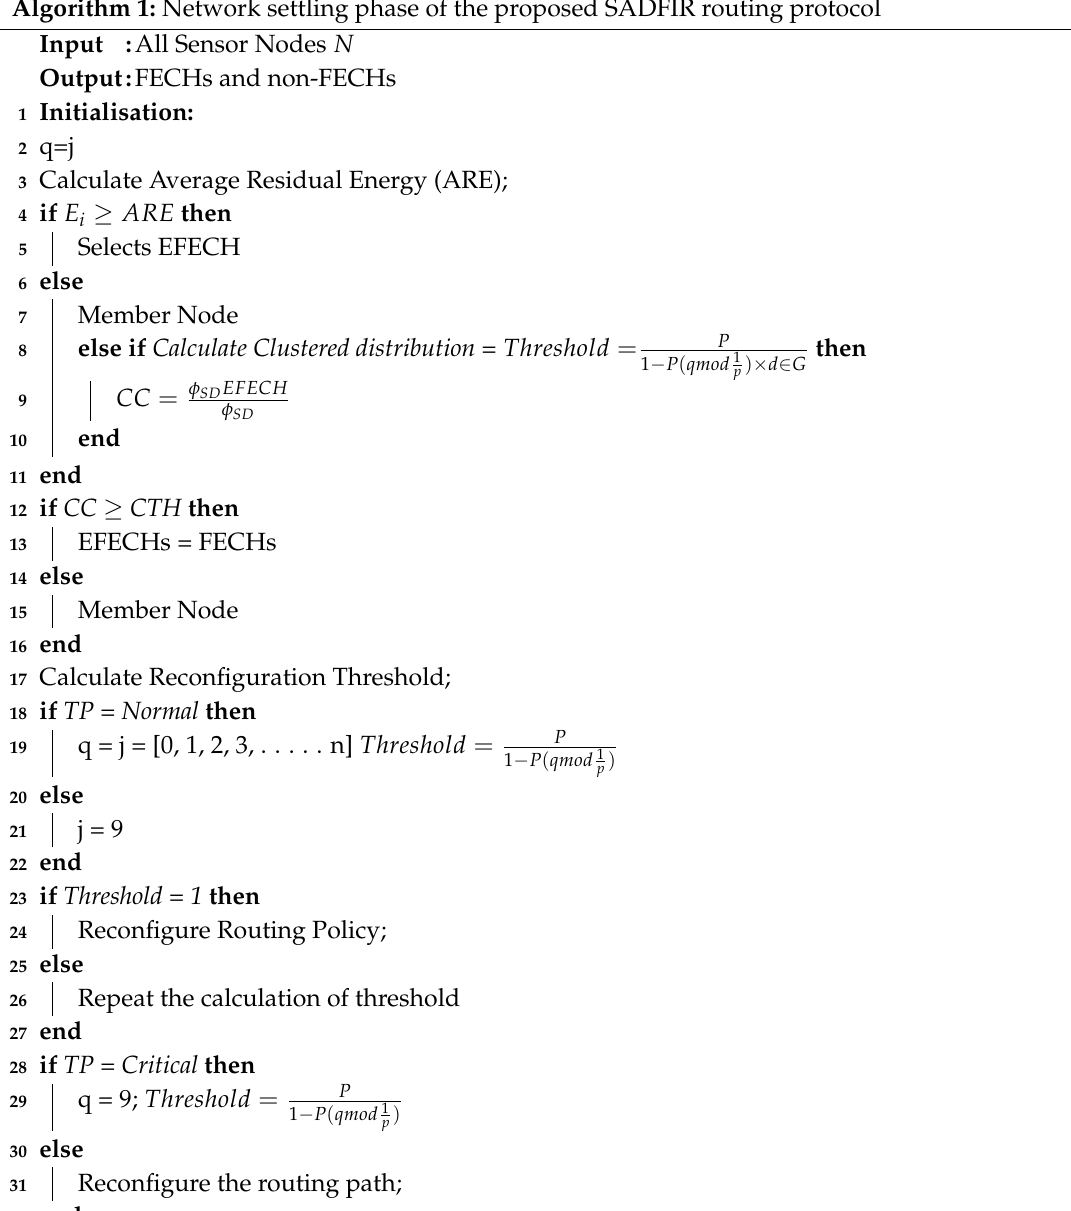
Algorithm 1: Network settling phase of the proposed SADFIR routing